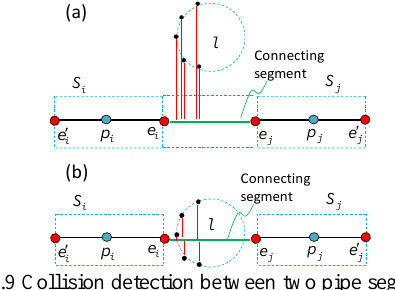
Fig.9 Collision detection between two pipe segments